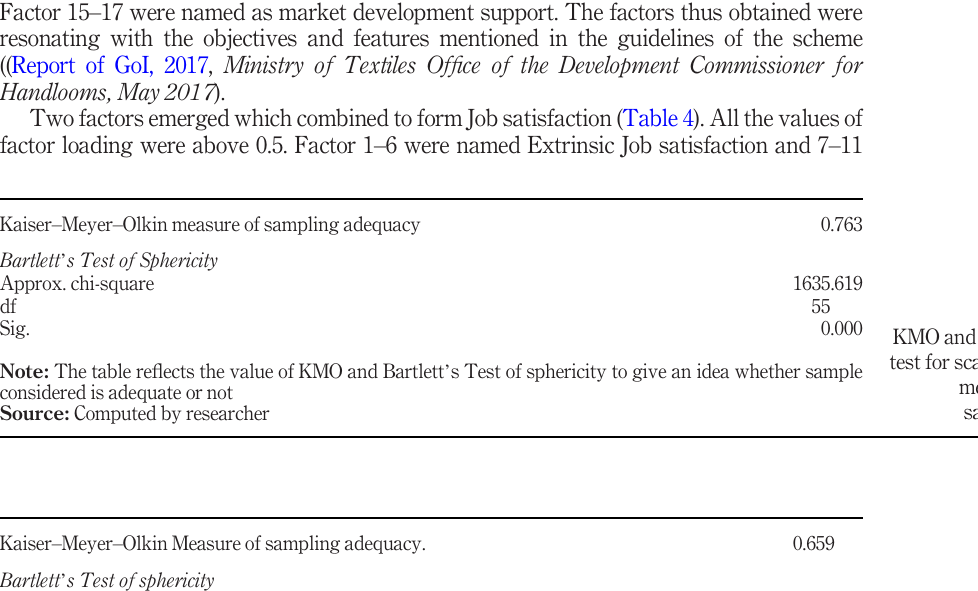
Table 3. KMO and Bartlett ’